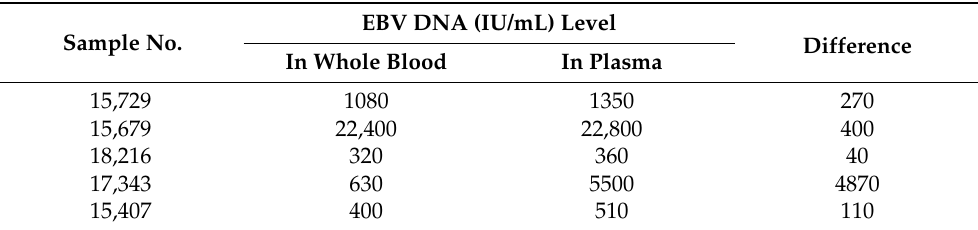
Table 3. The list of EBV DNA levels (IU/mL) for the samples with higher plasma ( n = 5) DNAemia when compared to the whole-blood counterparts ( n = 5).